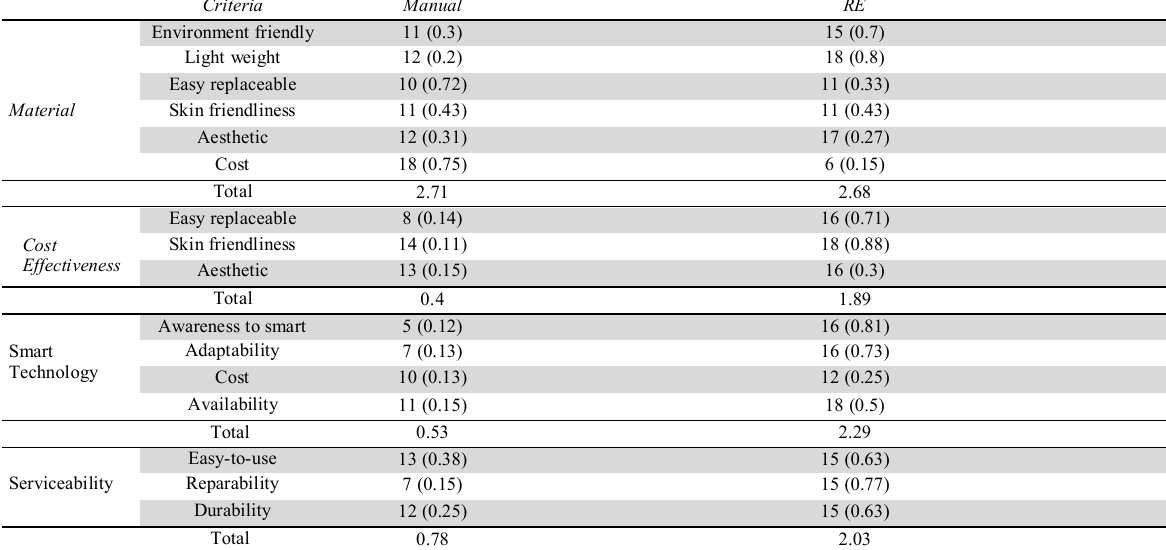
Linguistic data and scores for other parameters